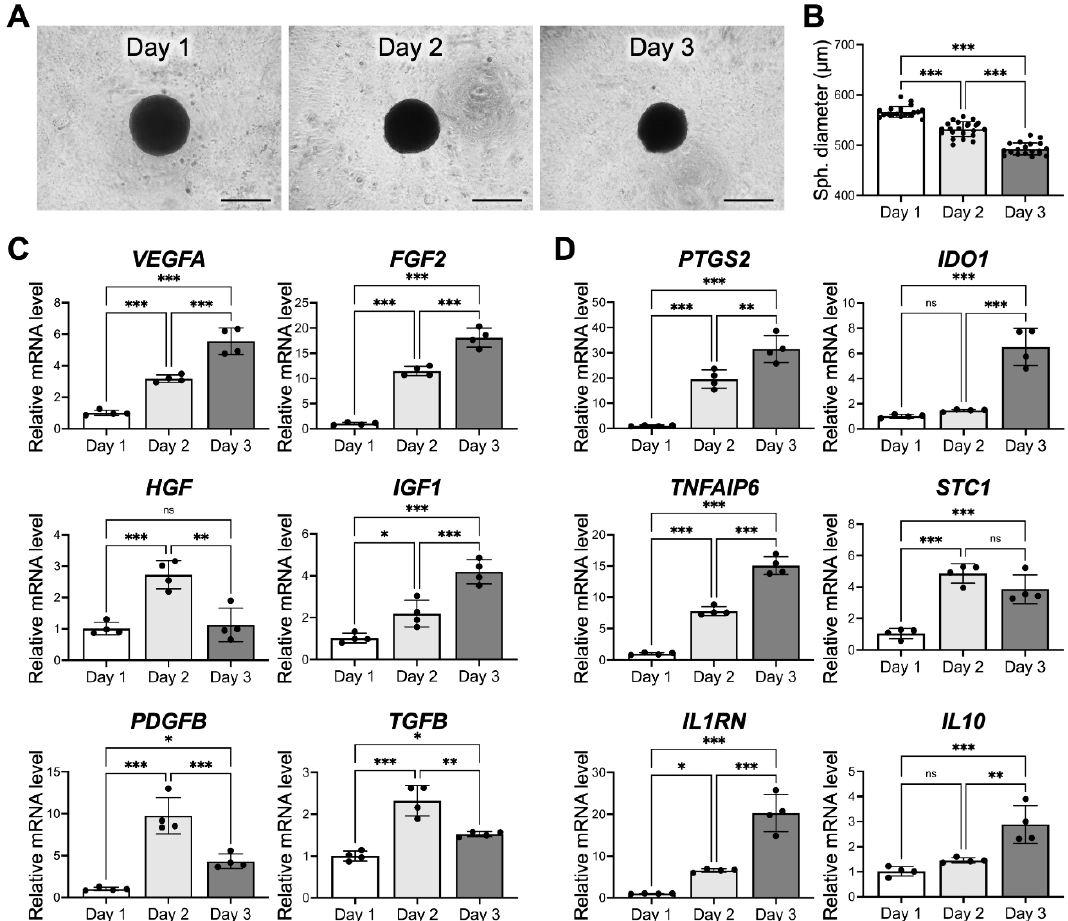
Figure 2. The culture period of 3D MSC spheroids affects their therapeutic potential. ( A ) Representative images show the morphologies of 3D MSC spheroids cultivated for various durations and ( B ) their corresponding diameters ( n = 21 spheroids pooled from 3 independent experiments, mean ± s.d.). Scale bars, 500 µm. The expression levels of multiple pro-regenerative genes that encode ( C ) paracrine signaling molecules and ( D ) immunomodulatory enzymes/cytokines by MSCs ( n = 4). * p < 0.05; ** p < 0.01; *** p < 0.001; ns: not significant.